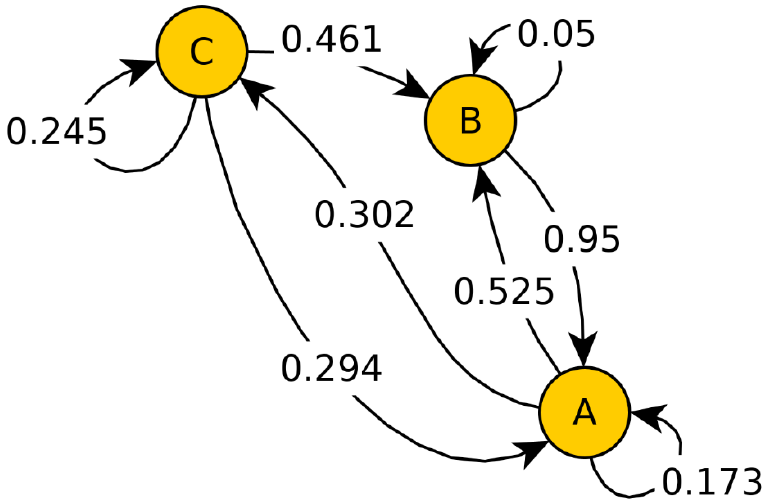
Figure 14. A snapshot of a network with transition probabilities. Single vertices represent geographic areas, and the edges between the paths can be covered within a fixed time window.